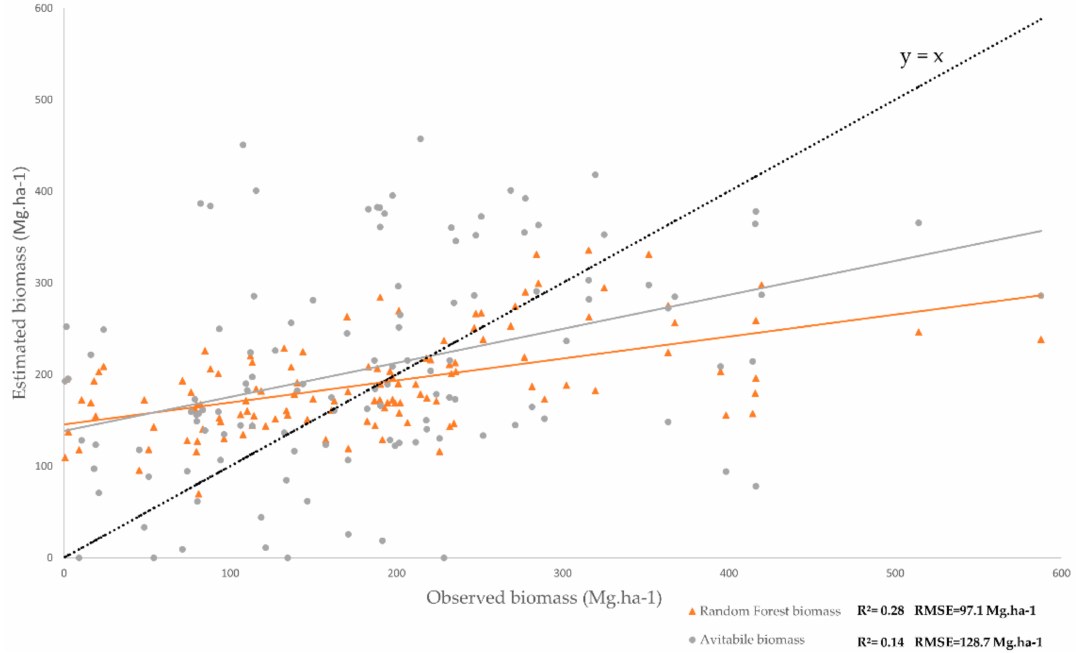
Figure 6. Observed (see Section 2.2) and estimated biomass from Avitabile [23] and the Random Forest